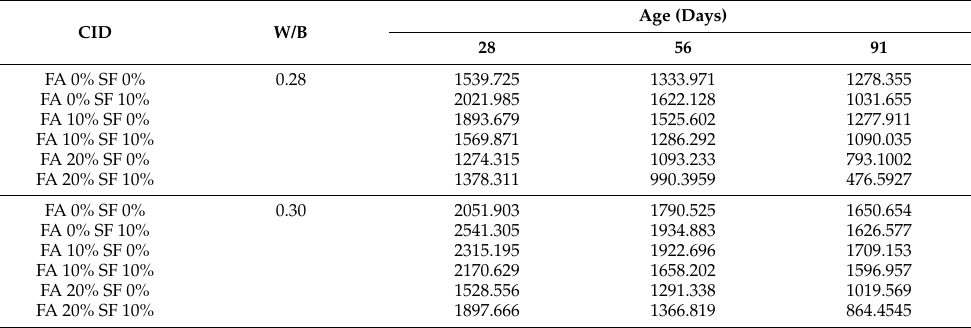
Table A5. Source data for the rapid chloride permeability test (unit: charge passed in